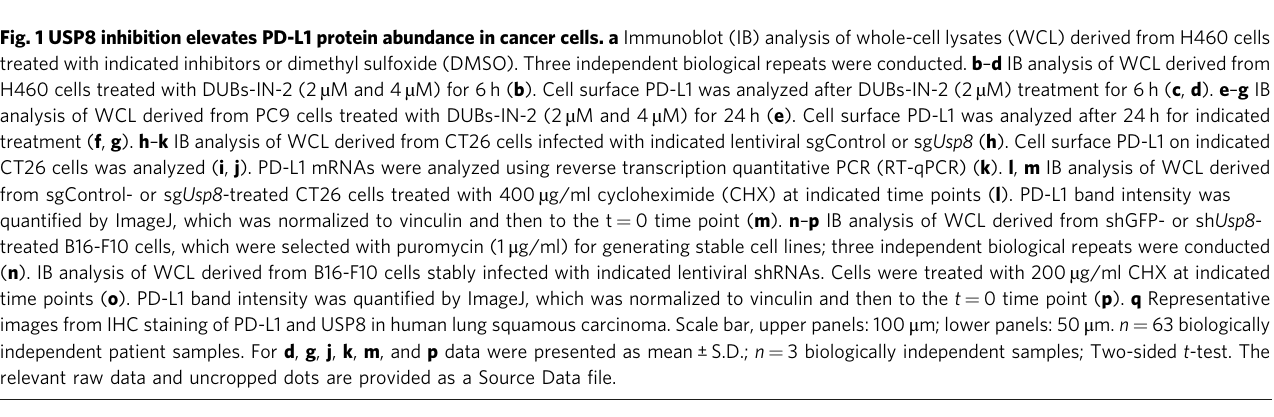
Fig. 1 USP8 inhibition elevates PD-L1 protein abundance in cancer cells. a Immunoblot (IB) analysis of whole-cell lysates (WCL) derived from H460 cells treated with indicated inhibitors or dimethyl sulfoxide (DMSO). Three independent biological repeats were conducted. b – d IB analysis of WCL derived from H460 cells treated with DUBs-IN-2 (2 µ M and 4 µ M) for 6 h ( b ). Cell surface PD-L1 was analyzed after DUBs-IN-2 (2 µ M) treatment for 6 h ( c , d ). e – g IB analysis of WCL derived from PC9 cells treated with DUBs-IN-2 (2 µ M and 4 µ M) for 24 h ( e ). Cell surface PD-L1 was analyzed after 24 h for indicated treatment ( f , g ). h – k IB analysis of WCL derived from CT26 cells infected with indicated lentiviral sgControl or sg Usp8 ( h ). Cell surface PD-L1 on